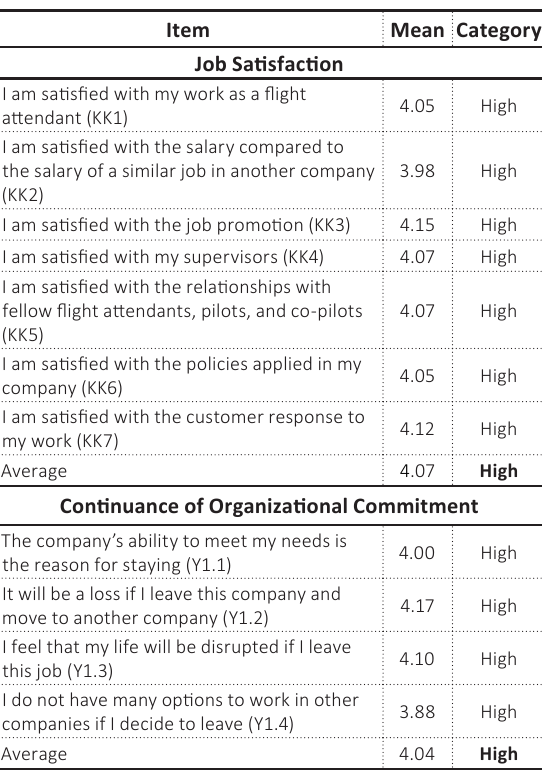
Table 3. Answer frequency